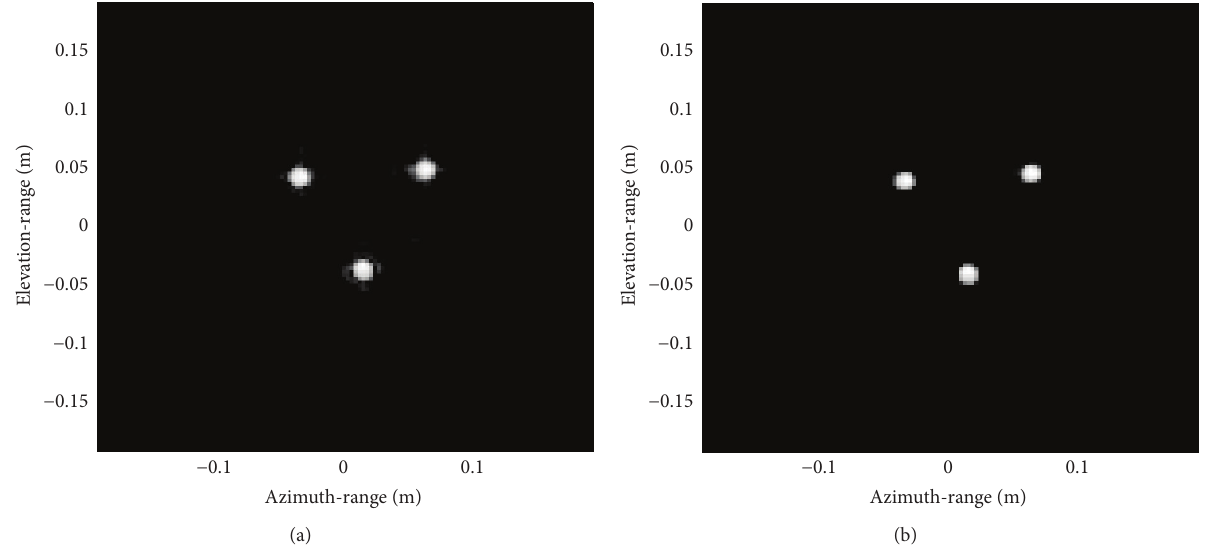
Figure 7: MMW images of the screws: (a) the result of WDA using the full data and (b) the result of the CS-based method using only 25% of the full data.